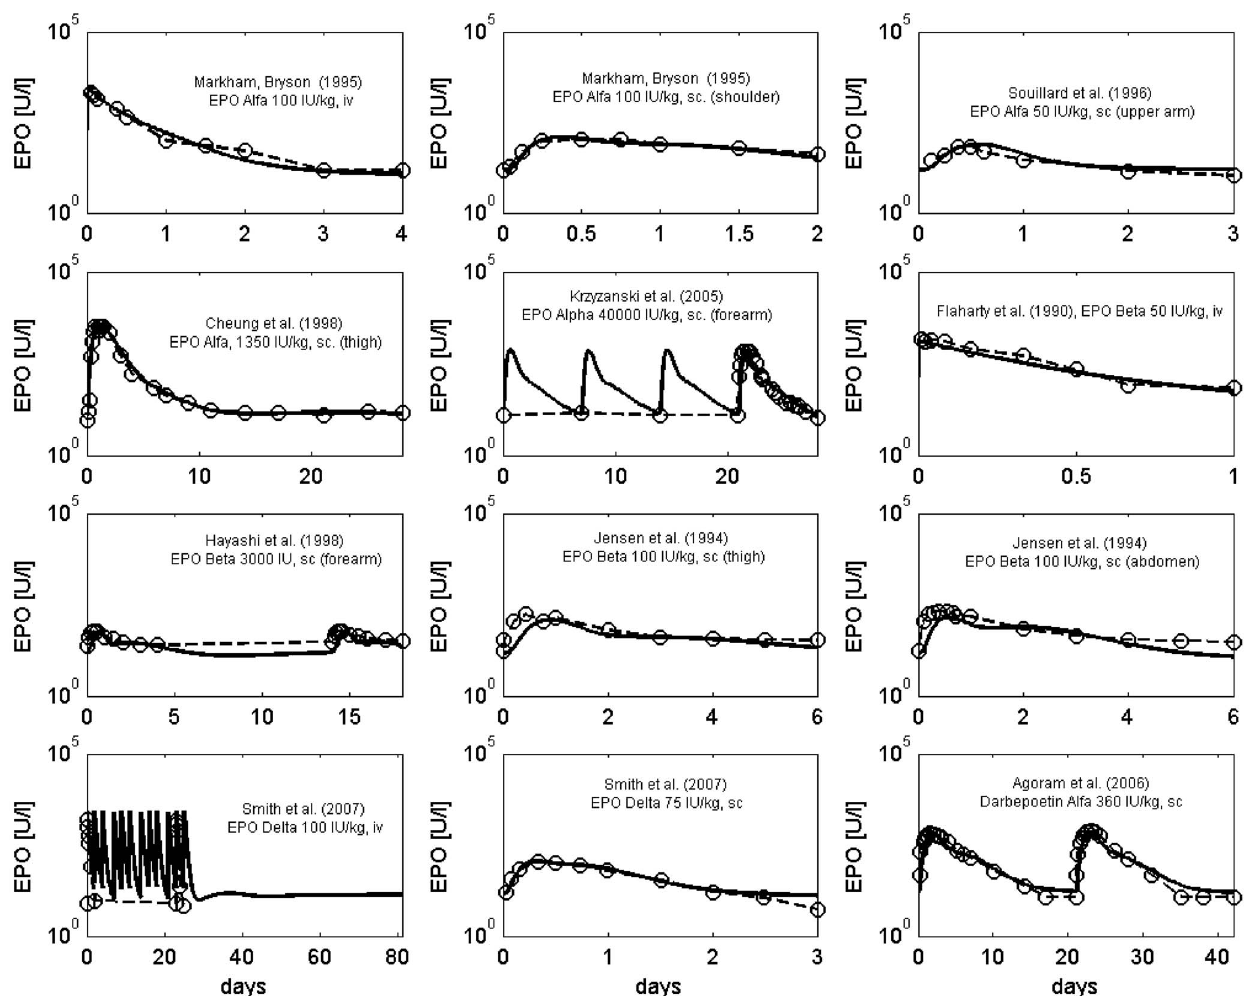
Figure 5. Comparison of model prediction and data of EPO serum concentration for different injection scenarios. The data are taken from the following literature: [13,26,31,33,54–58]. the most significant parameter influencing the haematotoxic outcome, we plot the stem cell toxicities against ERY-AOC in figure 9. We also plot RET-AOC against ERY-AOC. As expected,